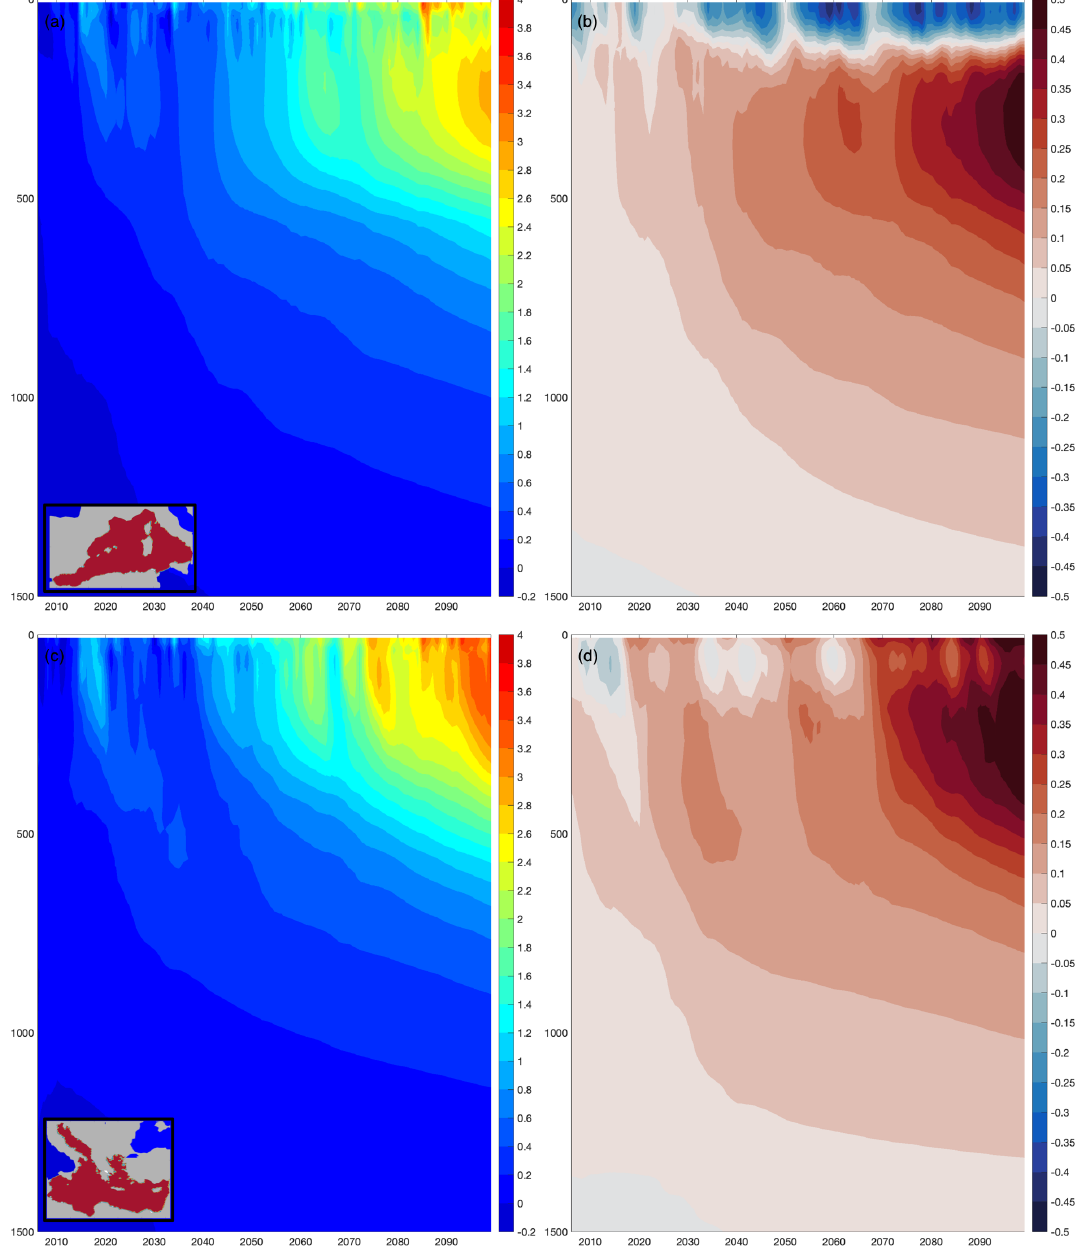
Figure 15. Temporal evolution of mean temperature ( a, c , in ◦ C) and salinity ( b, d , in psu) throughout the 21st century in the western (a, b) and eastern (c, d)